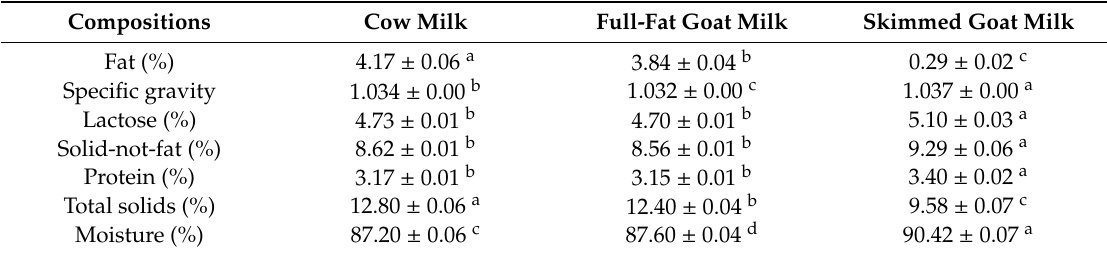
Table 1. Compositions of Holstein cow milk and Alpine goat milk (replicated for three different samples).